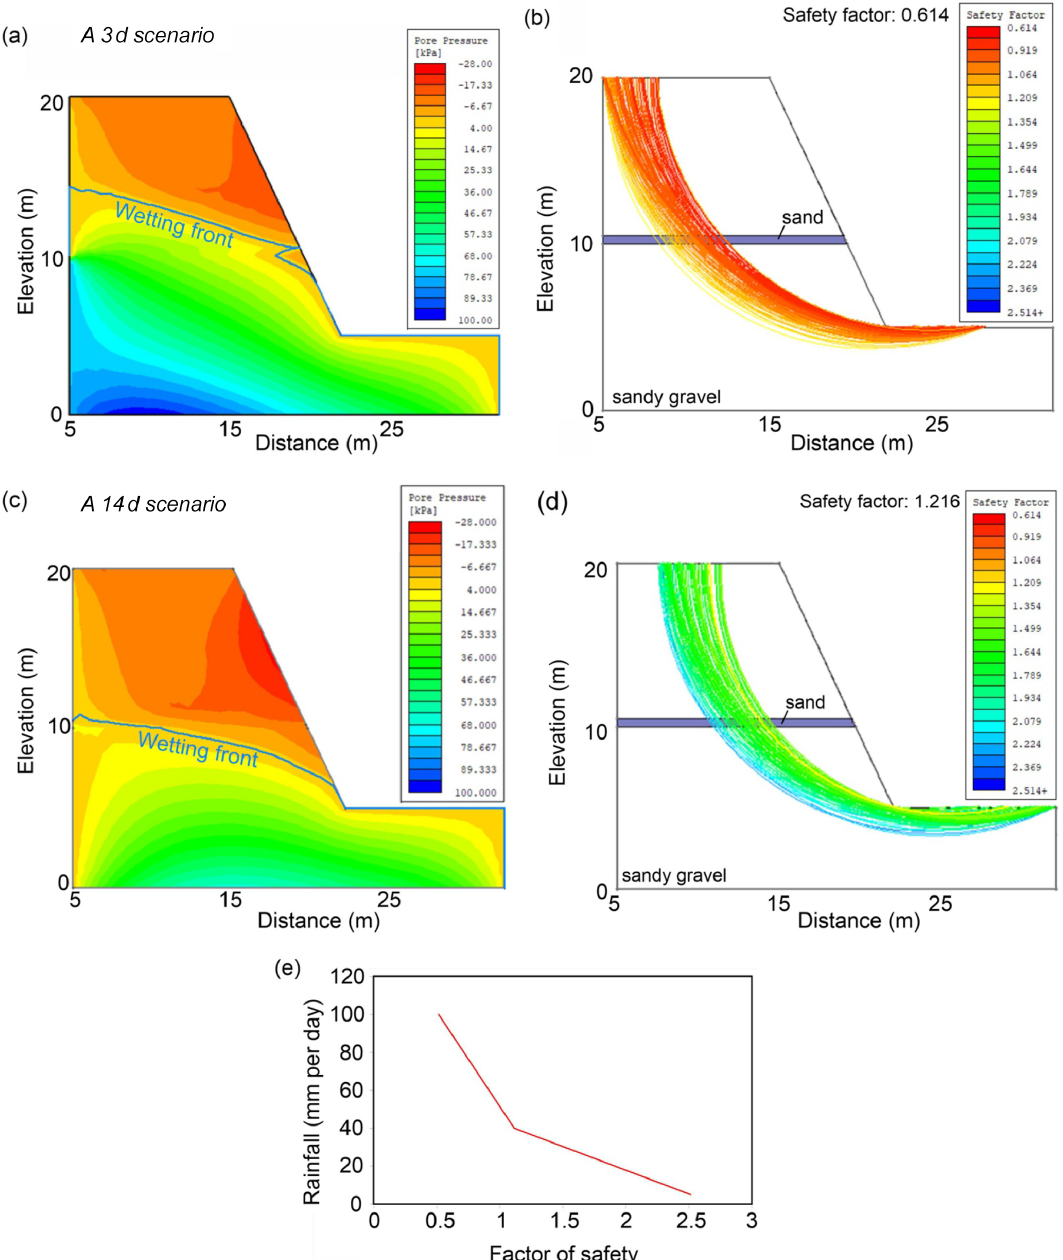
Figure 9. Model results for a sandy gravel slope with a sand lens. Estimated pore water pressure and factor of safety after 3d for the first scenario ((I-D) 3 ) (a–b) and 14d for the second scenario ((I-D) 14 ) (c–d) . (e) Plot of rainfall intensity vs. factor of safety for the for first scenario ((I-D) 3 ) for the slope with sand lens. The results shown are for the end of the simulation for each